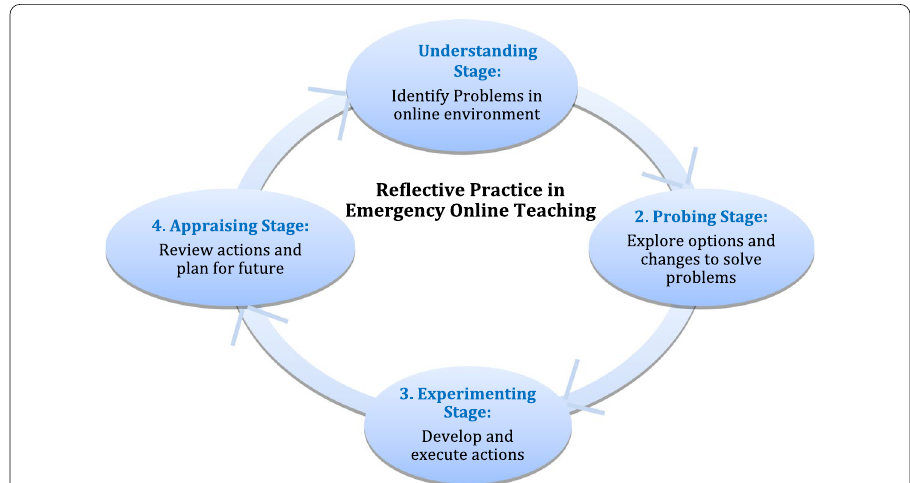
Fig. 1 Reflective practice cycle during emergency online